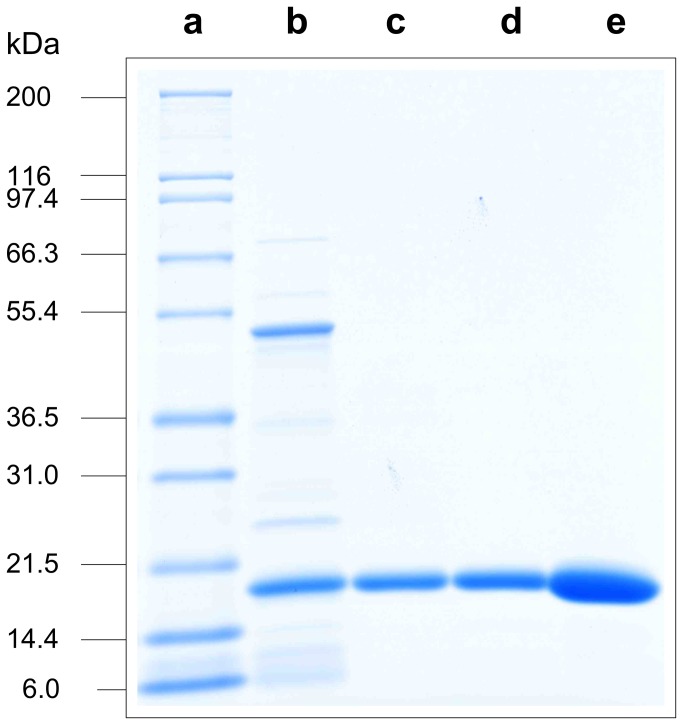
SDS-PAGE analysis of in-process controls.(a) Mark12™ Standard; (b) Purification step 1 elution pool; (c) Purification step 2 elution pool; (d) Purification step 3 elution pool; (e) Drug substance, HCP content: 30 ppm.